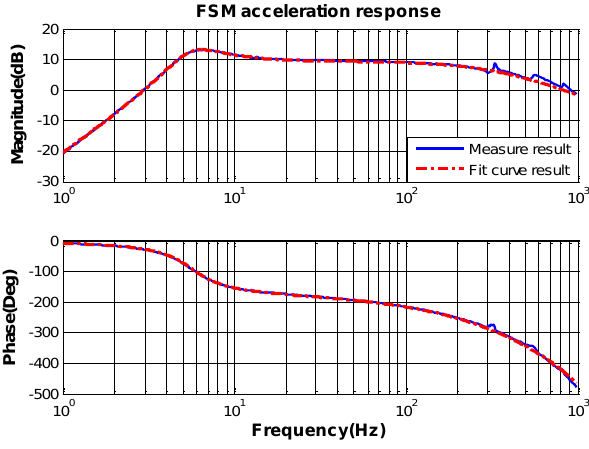
Figure 6. The opened loop characteristic of the FSM acceleration response.